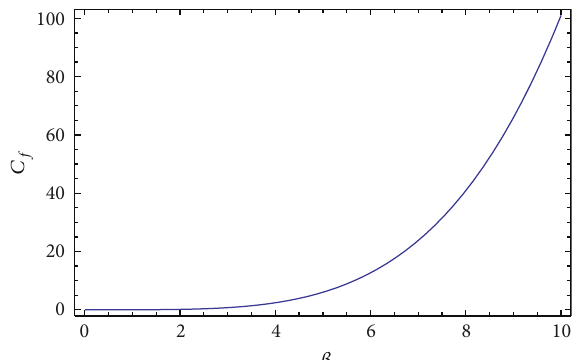
Figure 16: Variation of skin friction versus non-Newtonian param- eter 𝛽